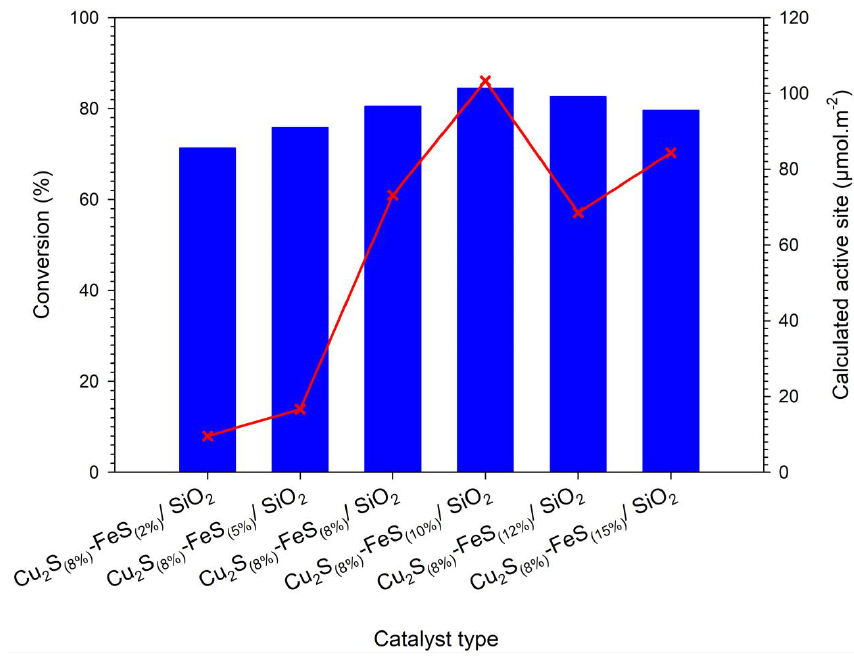
Figure 5. The relationship between CuS and FeS doping present with the biodiesel conversion; reaction conditions: reaction temperature 60 °C; reaction time 1 h; methanol to PFAD ratio 5:1 and catalyst loading 3% wt at ATM bar (5 g of PFAD in 50 mL round bottom flask at 900 rpm).